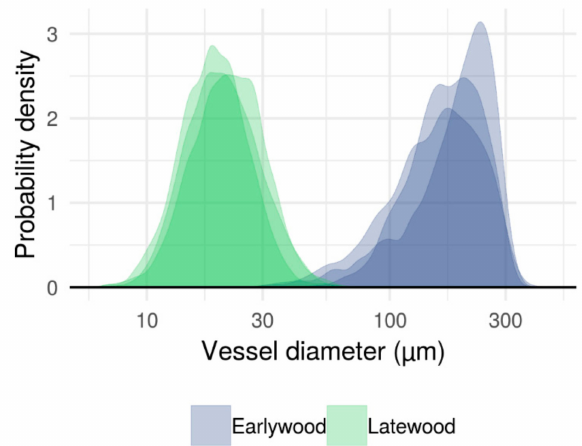
Figure 3. Empirical density plots of the observed vessel lumen diameter distributions in earlywood (blue) and latewood (green) separated by tree individuals (please note that the X-axis is displayed on a logarithmic scale). See Figure S1 for a breakdown by axial height and wood